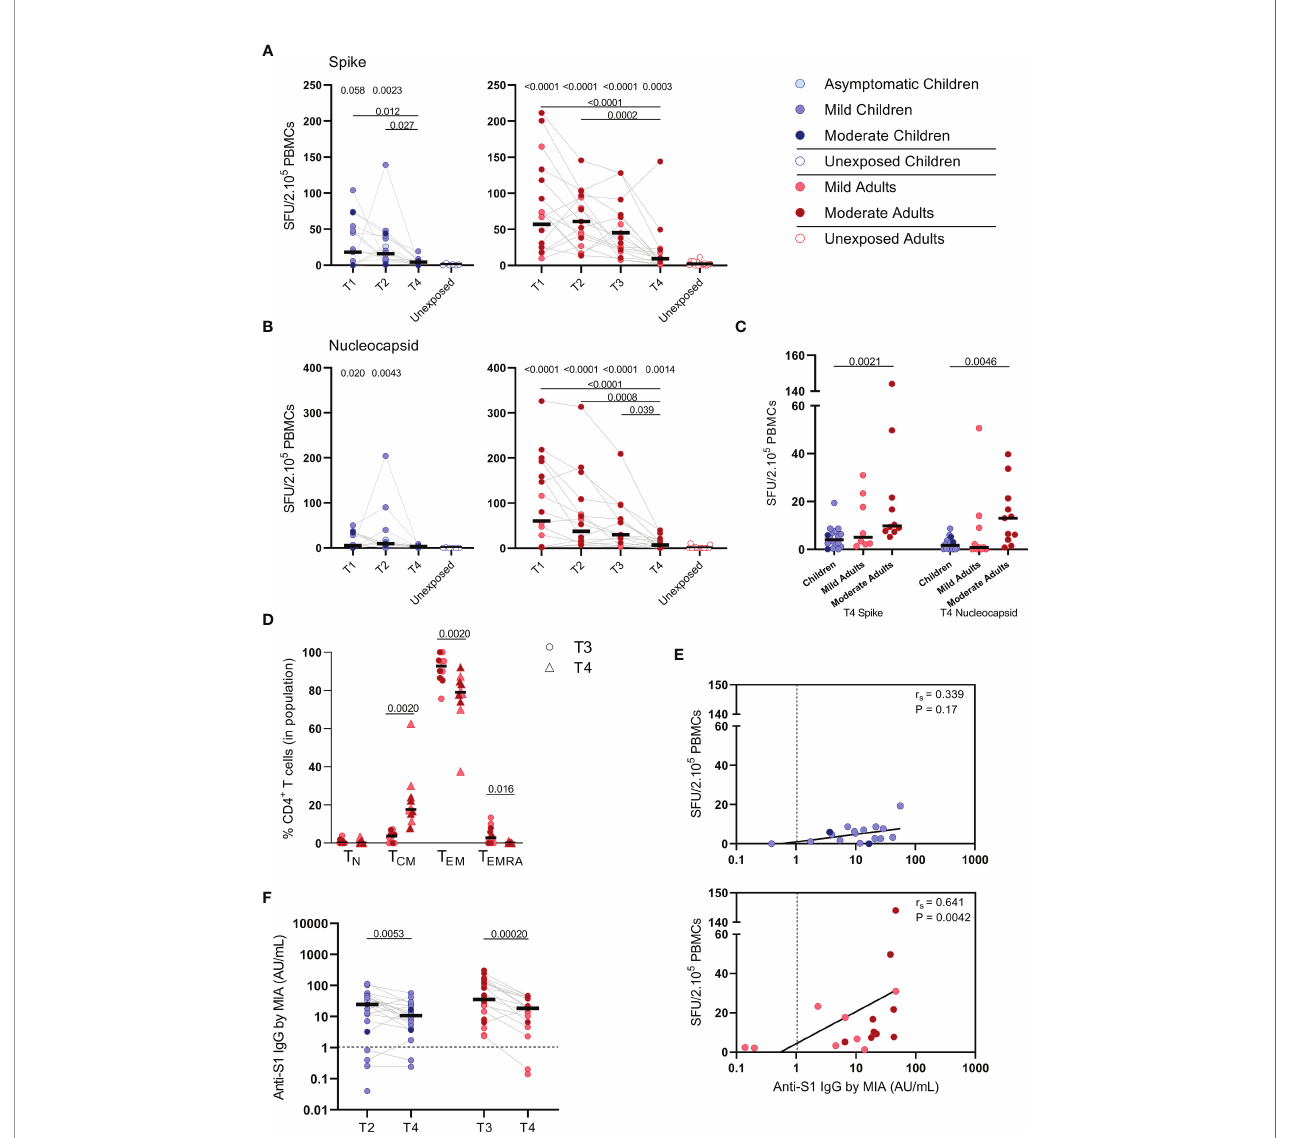
FIGURE 6 | SARS-CoV-2-speci fi c immune response up to 10 months after infection. Dot plots summarizing the frequencies of IFN- g -producing cells by ELISPOT assay responding to (A) a set of overlapping peptides of SARS-CoV-2 spike protein and (B) a set of overlapping peptides of SARS-CoV-2 nucleocapsid protein in children (left panel, blue) and adults (right panel, red), at different time points after infection, and compared to unexposed children/adults. (C) Dot plots showing the frequencies of IFN- g -producing cells responding to SARS-CoV-2 spike and nucleocapsid proteins, at 10 months after symptom onset (T4) comparison of groups of children versus total, mild, and moderate adult cases separately. (D) Immunophenotyping at the single-cell level comparing the frequencies of different memory subsets from T3 versus T4 within the SARS-CoV-2-speci fi c activated CD4+ T cells from infected adults. (E) Spearman correlation between frequency of IFN- g + responder cells and concentrations of anti-spike-S1 IgG serum antibodies measured by multiplex immunoassay (MIA) at T4 in children (upper panel, blue) and adults (lower panel, red). (F) Dot plots comparing the concentrations of anti-spike-S1 IgG serum antibodies at T2 or T3 versus T4 in children and adults. Each dot represents one subject. Bars indicate the median. SFU, spot-forming unit. (A, B) P values related to comparisons with the unexposed controls are listed at the top of the graph, above the corresponding group for comparison. For unpaired comparisons, Mann-Whitney U test (two-group comparisons) (mild adults versus moderate adults, infected children or adults at T4 versus unexposed children or adults) or Kruskal-Wallis rank-sum test with Dunn ’ s post hoc test for multiple comparisons were used (children versus total adults versus mild adults versus moderate adults; unexposed versus infected children or adults at T1 versus T2 versus T3). Differences between paired data were compared using the Wilcoxon signed-rank test (for comparison of two paired groups) (memory T cell subsets at T3 versus T4; concentrations of anti-spike-S1 IgG serum antibodies at T2 or T3 versus T4) or the Friedman test with Dunn ’ s multiple comparison tests (infected children or adults at T1 versus T2 versus T3 versus T4). Statistically signi fi cant comparisons are indicated, with P values < 0.05 considered signi fi cant. Cut-off values for seroprevalence are indicated with vertical dotted lines in (E, F) . Correlation coef fi cients (rs) were determined with Spearman ’ s rank correlation. Statistically signi fi cant comparisons are indicated. P values < 0.05 were considered signi fi cant. T1, fi rst timepoint of sampling for adults median 12.5 days and children median 8 days post-symptom onset; T2, 10-14 days after T1; T3, 4-6 weeks after T1; T4, 10 months ± 13 days after symptom